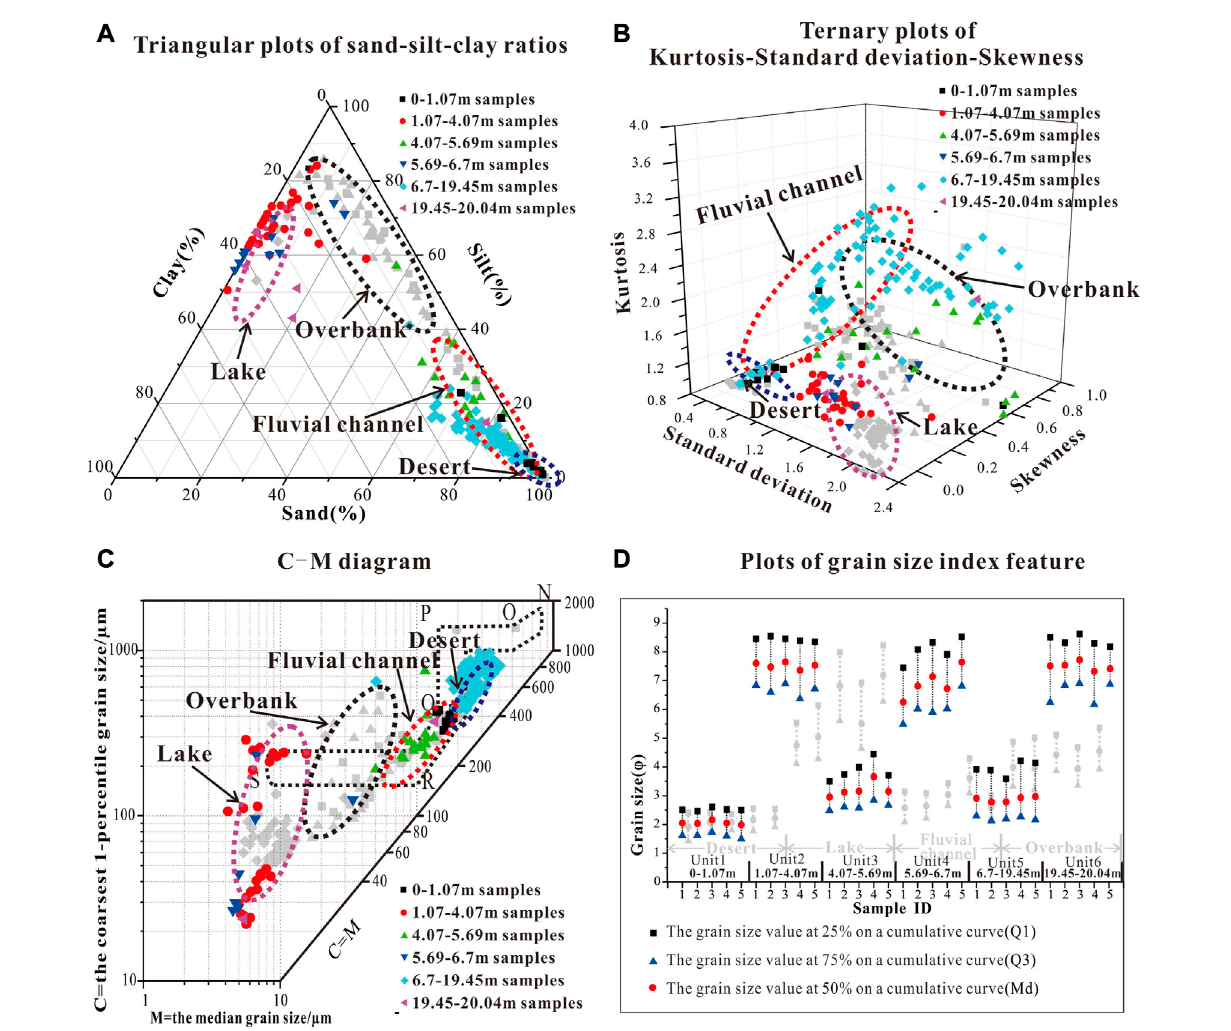
FIGURE 4 (A) Triangular plots of sand – silt – clay ratios in different units. (B) Ternary plots of kurtosis – standard deviation – skewness in different units. (C) C – M diagram of core sediments. (D) Grain-size index feature graphic of core sediments in different units. Gray scatters represent the modern samples from different sedimentary environments (Li et al., 2019). Note that the modern samples from different sedimentary environments occupy different areas.